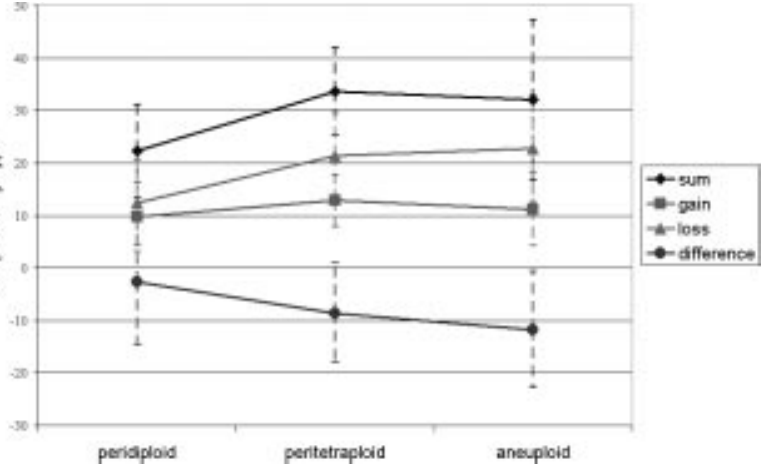
Fig. 3. Chromosomal imbalances in correlation to the normal karyotype (PERNK). The vertical lines represent the standard